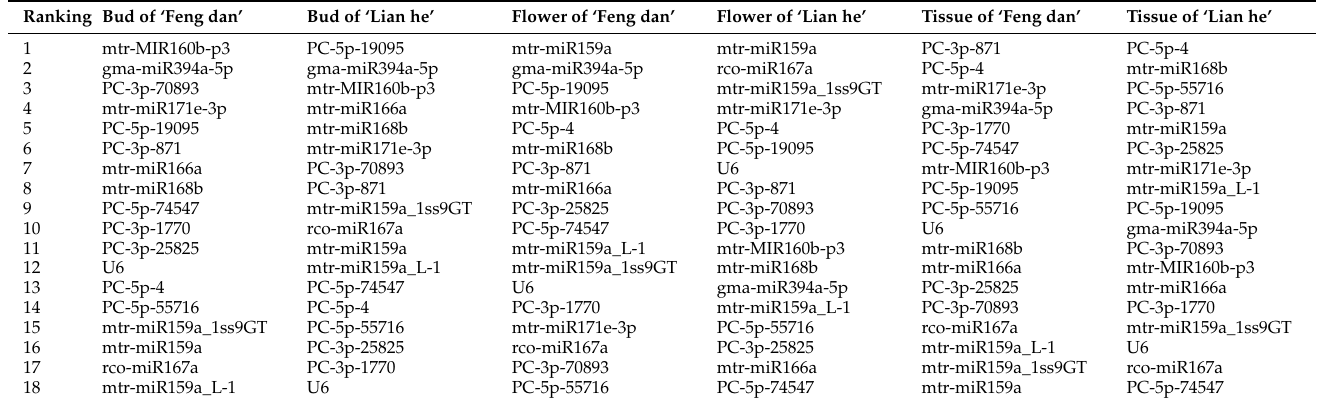
Table 2. Ranking of the candidate reference miRNAs calculated by